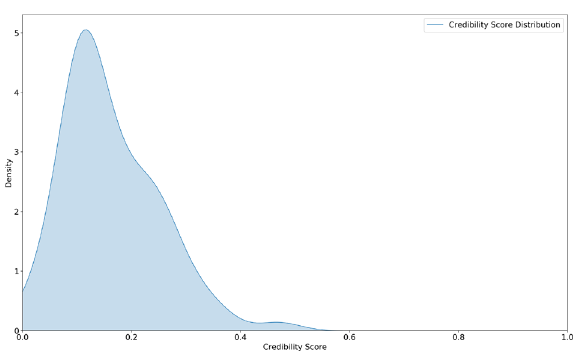
Figure 3. Credibility score